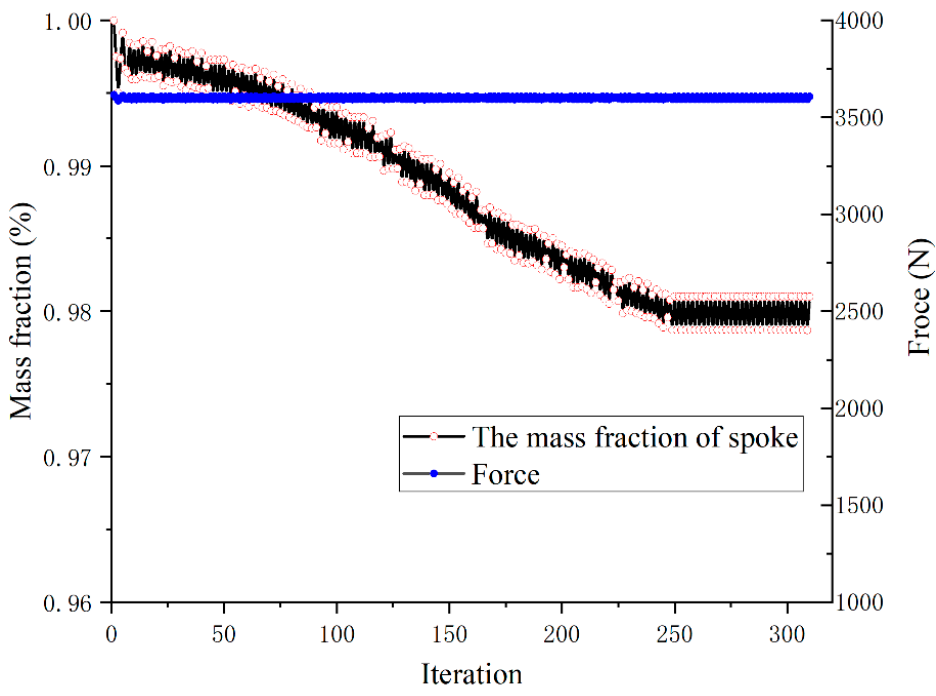
Figure 15. Optimized iterations for thickness in tire-width direction.